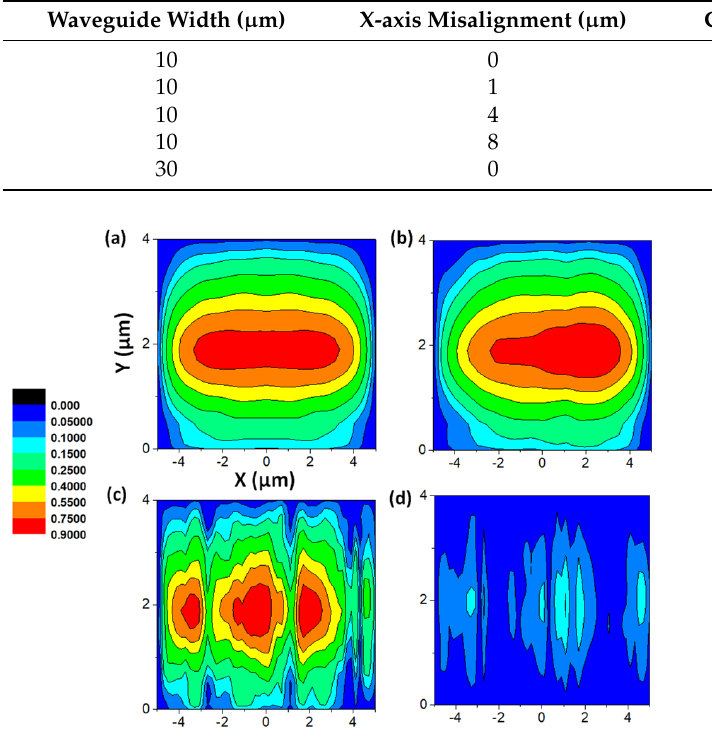
Figure 5. Spatial distribution in the XY-plane of the output light intensity from a waveguide (4 µm × 8 µm) at 600 nm under excitation with an SMF28 (butt-coupling configuration) for different X-axis misalignments of: ( a ) 0 µm (perfect case), ( b ) 1 µm, ( c ) 4 µm, and ( d ) 8